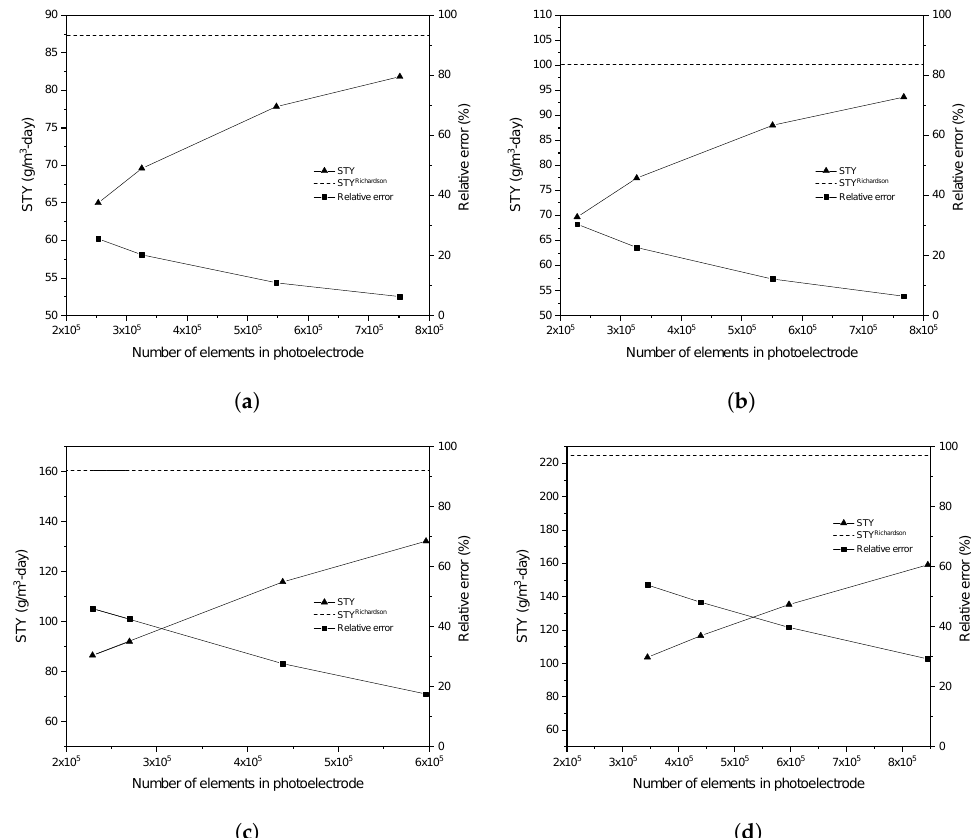
Figure 8. Convergence results for STY for ( a , c ) AF and ( b , d ) TF configuration in laminar ( a , b ) and turbulent ( c , d )